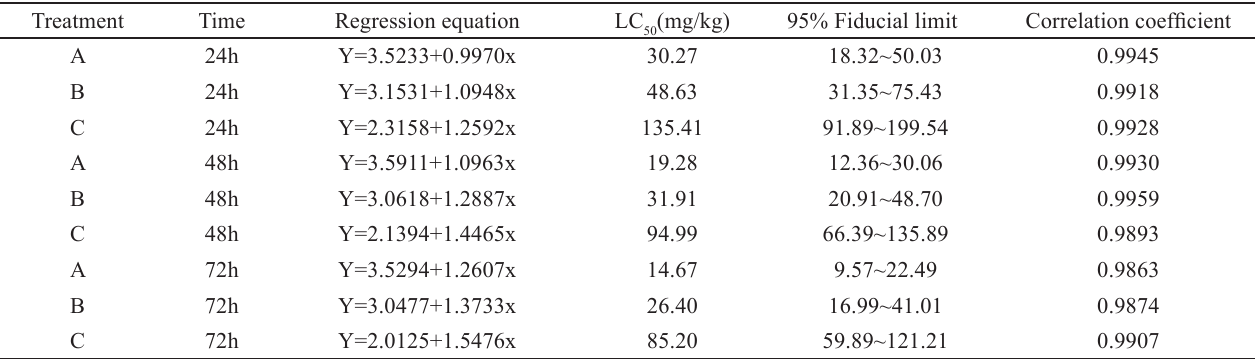
Table 2 . LC50(mg/kg) of D. trifoliata roots estract, T. vogelii leaves extract, and rotenone against macroergates of RIFA.